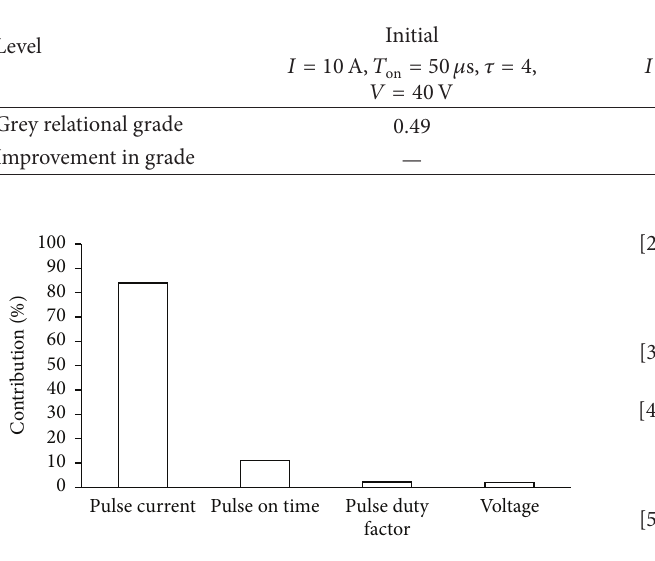
Figure 5: Contribution of each